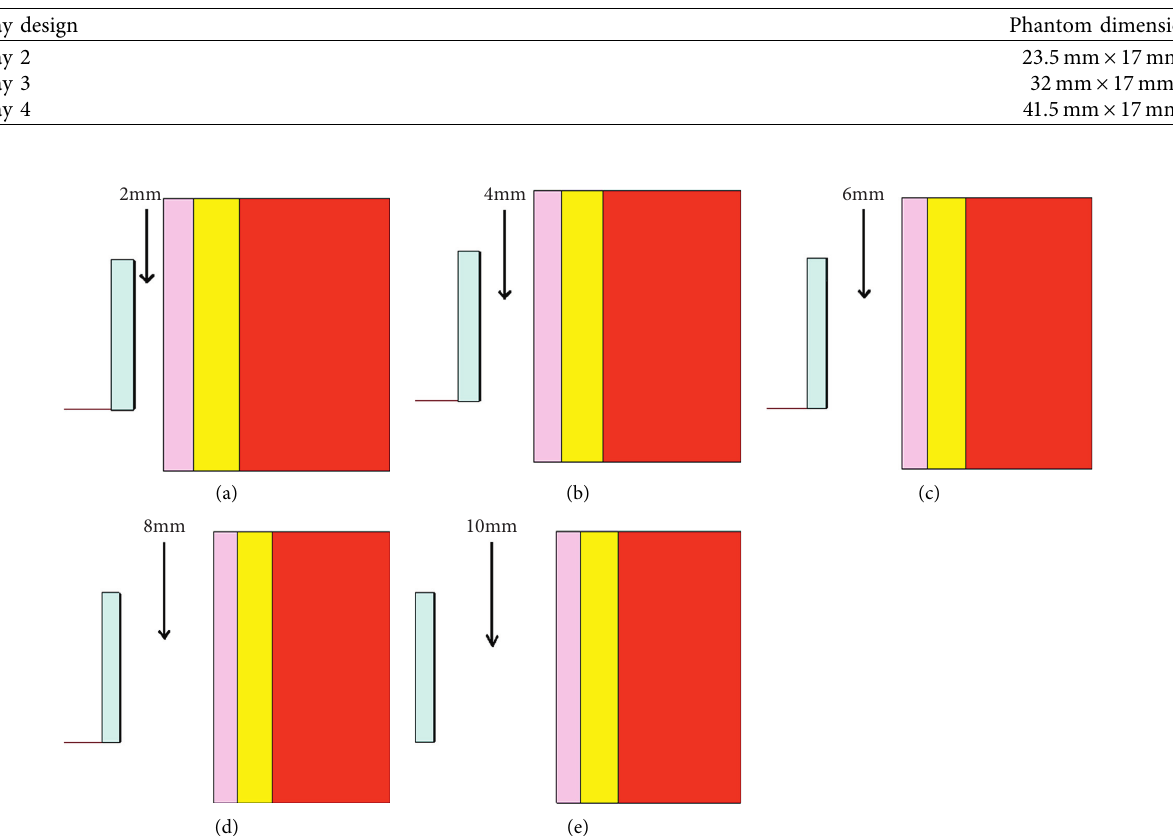
Table 7: Phantom dimension for different array configuration.